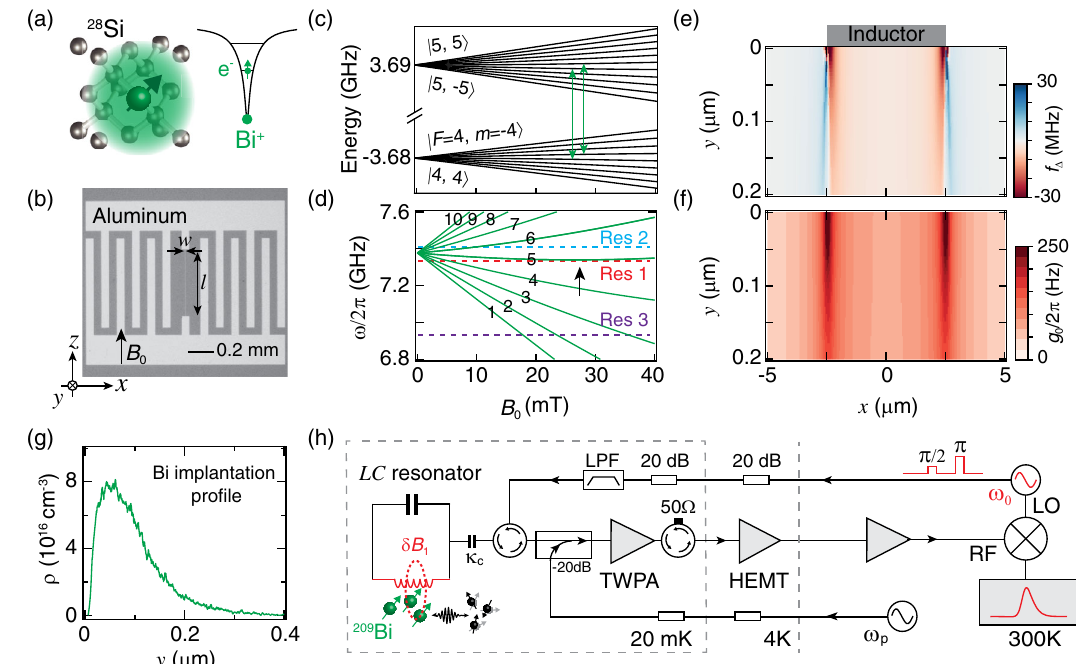
FIG. 1. Bismuth spins in silicon coupled to LC resonators. (a) A schematic of a bismuth atom and associated electron cloud in the silicon lattice. The donor electron stays bound to the Bi þ core at low temperatures due to Coulomb potential. (b) Optical picture of one of the 50 nm thick aluminum LC resonators directly fabricated on the Si substrate ( xz plane and y ¼ 0 ). The inductor is of width w and length l , while inter-digitated finger capacitors are 50 μ m wide and apart. (c) Numerically calculated eigenenergies j F; m i and (d) EPR allowed transition frequencies of Si:Bi at low magnetic fields. Transitions are numbered for referencing. A clock transition near 27 mT is marked by the arrow. (e) Strain induced Larmor frequency shift f Δ and (f) spin-photon coupling strength g 0 for the first transition in Res1. (g) The implantation profile ρ ð y Þ of the Bi dopants. (h) The measurement setup at different temperature stages. Input pulses are sent through a series of attenuators and low pass filters (LPF). The reflected output signals are routed via a circulator and amplified with a Josephson traveling wave parametric amplifier (TWPA) before further amplification and demodulation at room temperature. The shallow-implanted Bi spins interact with fluctuating impurity spins on the substrate surface, and are detected via inductive coupling to the